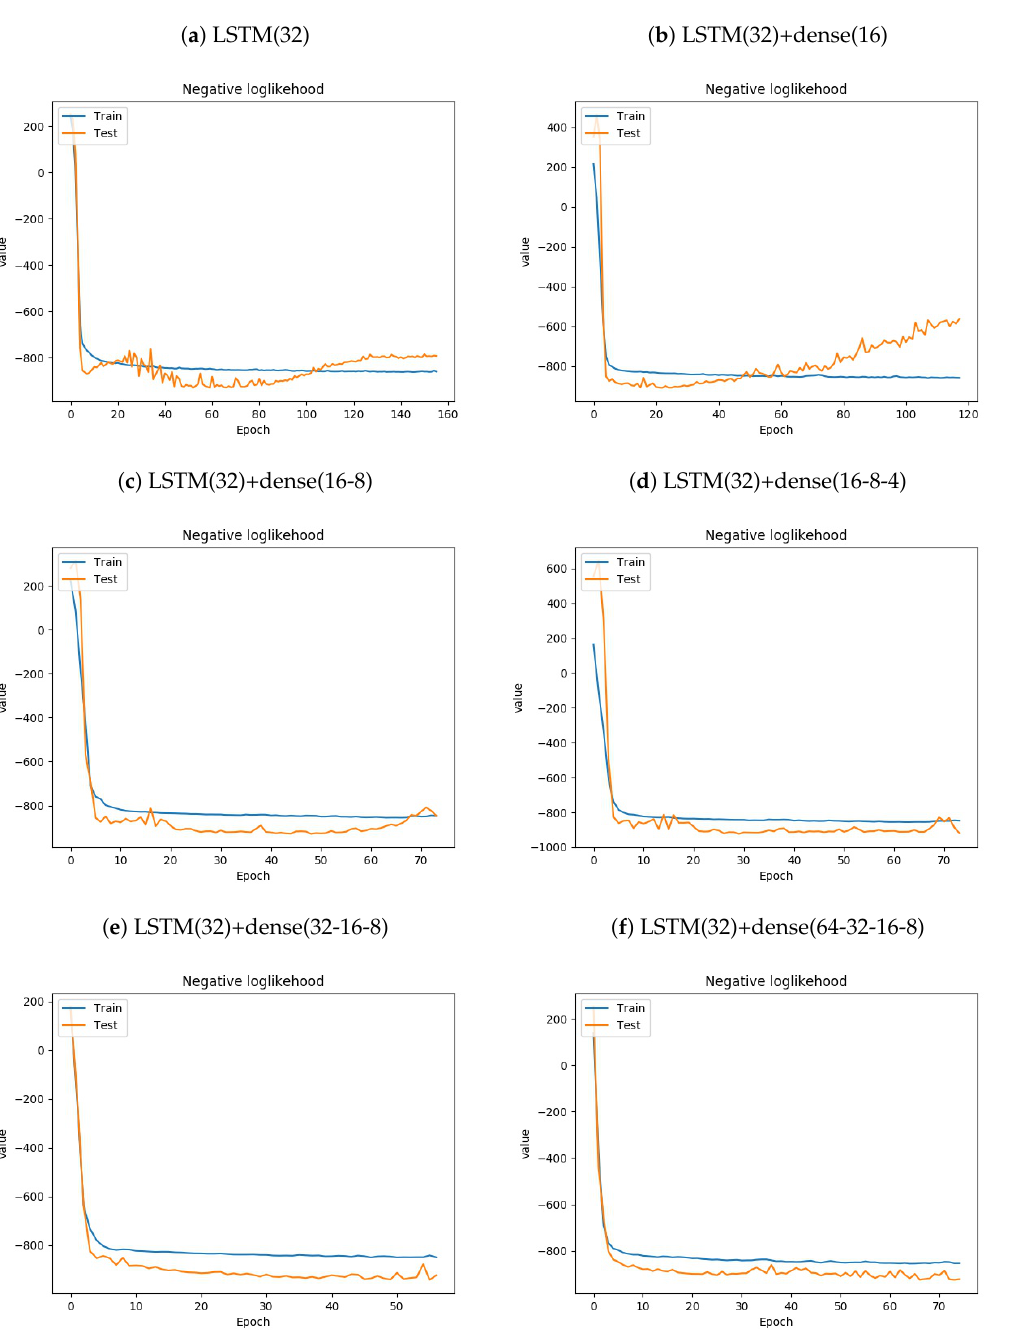
Figure 4. Negative loglikelihood over training. To observe whether overfitting occurs during training, we plotted the negative loglikelihood over training. Except for LSTM(32)+dense(64-32-16-8), the negative loglikelikehood for testing instances decreases over